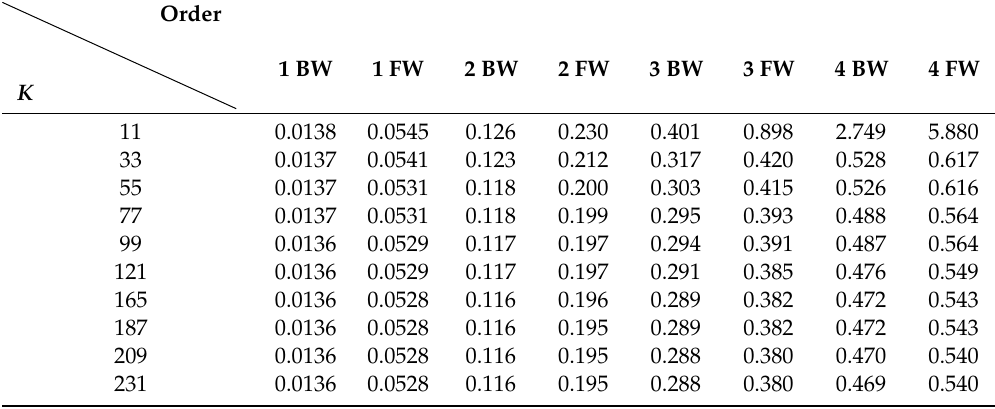
Table 4. Natural frequencies via modal discretization ( h = 300